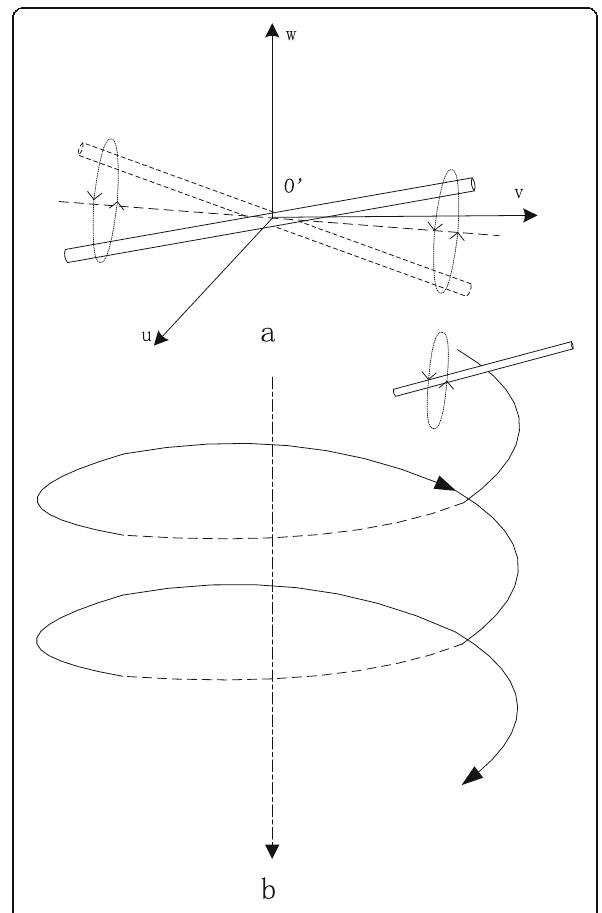
Fig. 2 Progressive model of a single chaff dipole precession motion: a the conical motion of a chaff dipole and b a falling chaff dipole at a constant angular